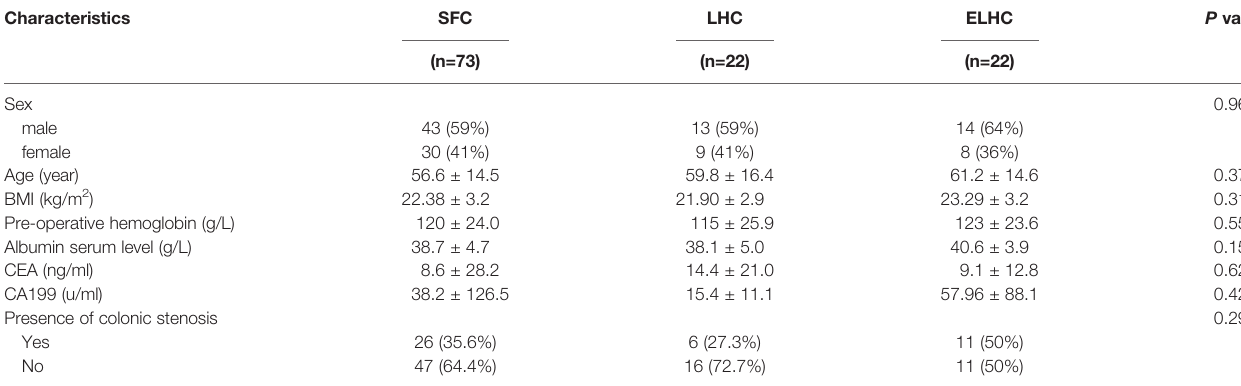
TABLE 1 | Demographics of patients treated by SFC, LHC or ELHC for splenic fl exure cancer.